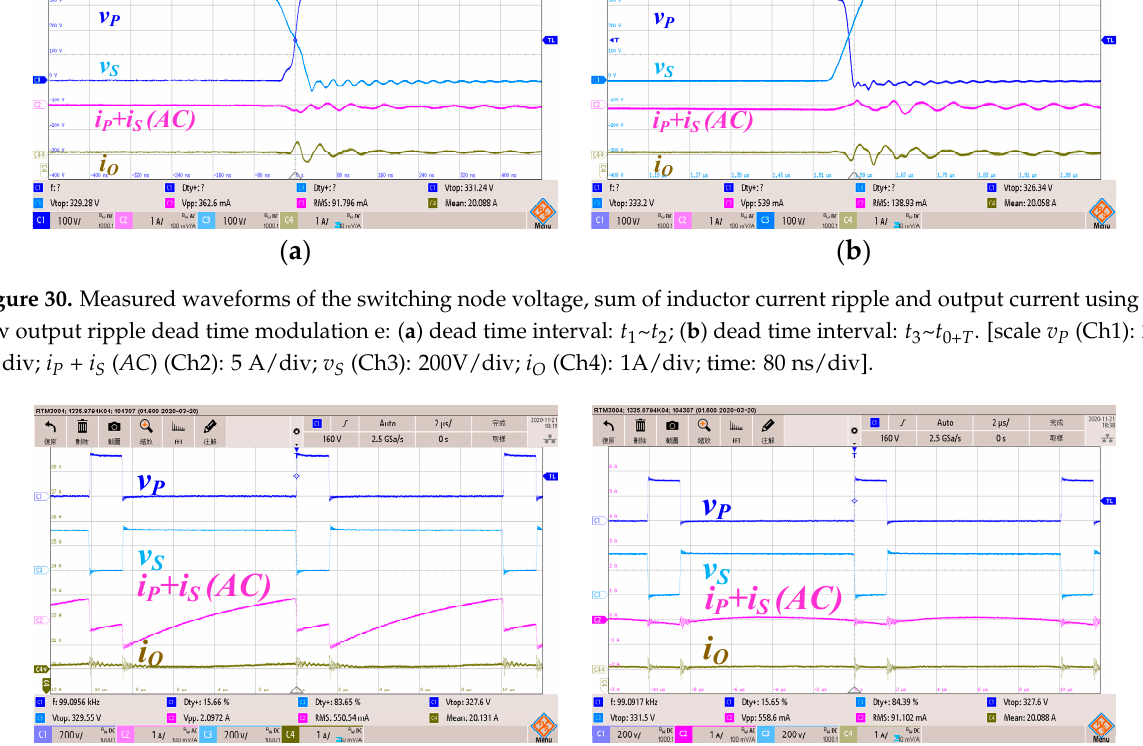
Figure 30. Measured waveforms of the switching node voltage, sum of inductor current ripple and output current using the low output ripple dead time modulation e: ( a ) dead time interval: t 1 ~t 2 ;